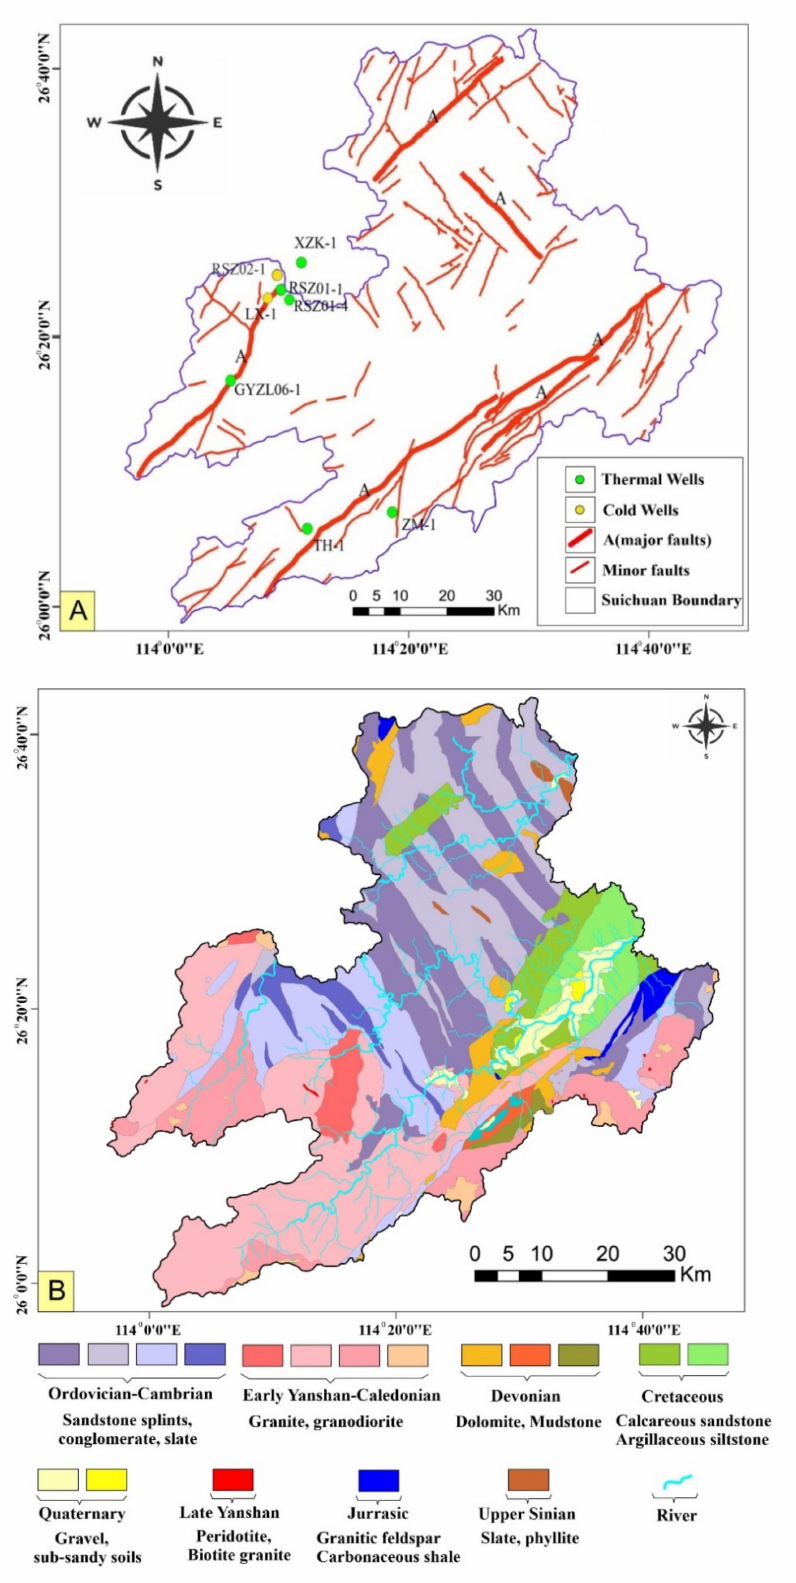
Figure 2. Simplified structural map ( A ) and geological map ( B ) of the study area showing thermal and cold well sites, major and minor faults indicating